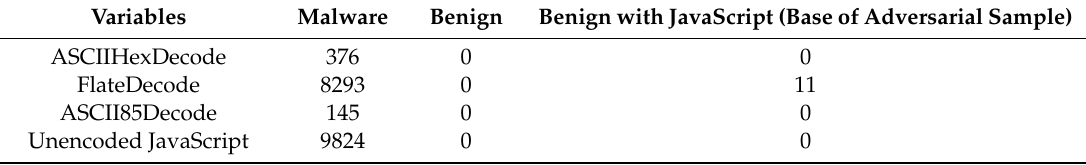
Table 1. The number of times that an encoding method is applied over all documents per class.